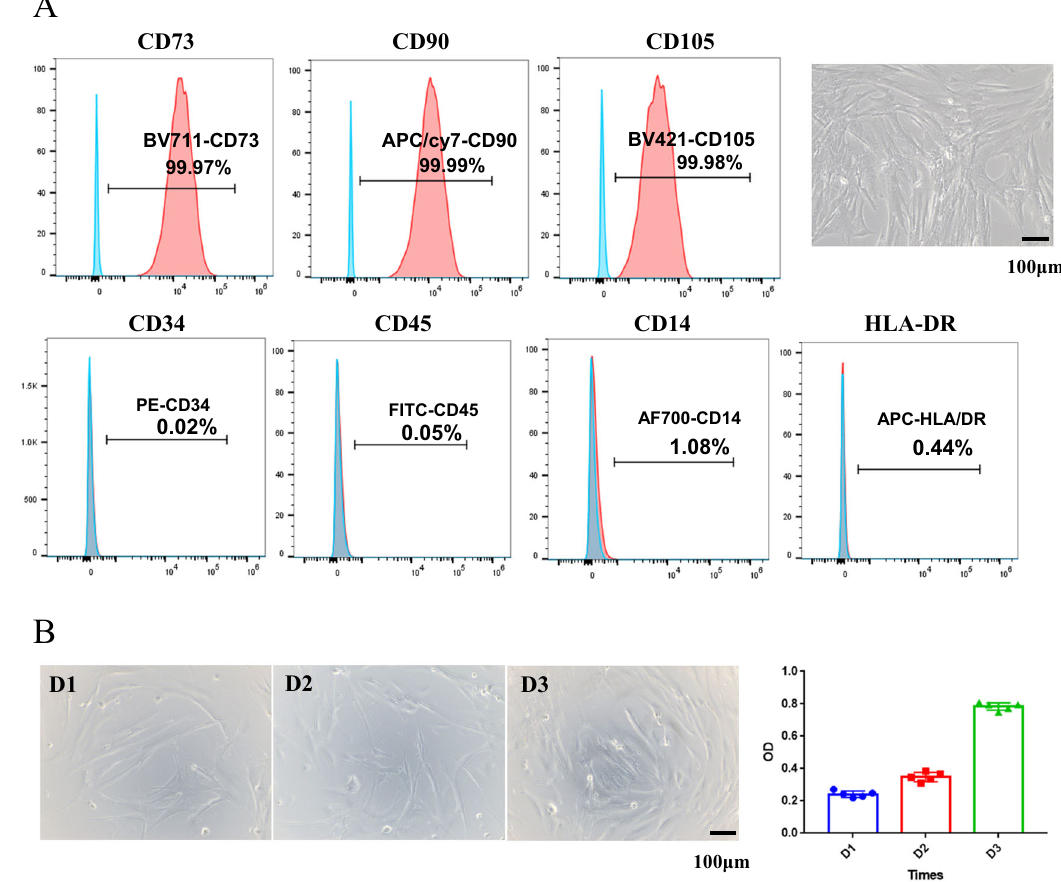
Fig. 2 Immunophenotypical analysis of hUMSCs. A HUMSCs were labeled with speci fi c antibodies for the indicated MSCs (upper panels) or hematopoietic (bottom panels) markers and analyzed by fl ow cytometry. B Evaluation of hUMSCs proliferation at 1st, 2nd, 3rd day